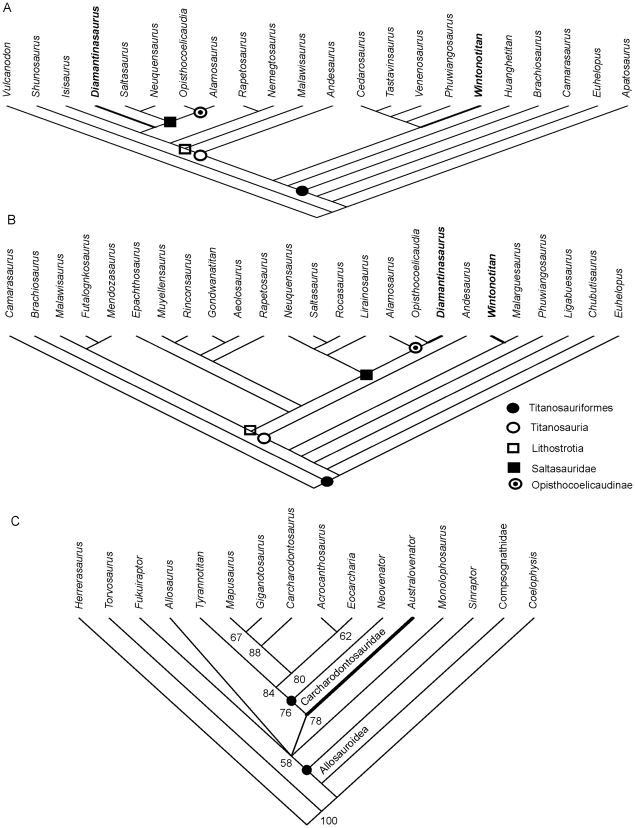
Phylogenetic position of the three new dinosaurs.A–B. Diamantinasaurus matildae and Wintonotitan wattsi. Most-parsimonious tree (MPT) from first analysis (tree length (TL) = 325 steps; consistency index (CI) = 0.64; retention index (RI) = 0.99) (A) and MPT from the second analysis (TL = 220; CI = 0.58; RI = 0.93) (B). C. Phylogenetic position of Australovenator wintonensis. Strict consensus tree of 5 MPTs (TL = 181; CI = 0.59; RI = 0.91). Bootstrap values provided at the nodes (>50%).